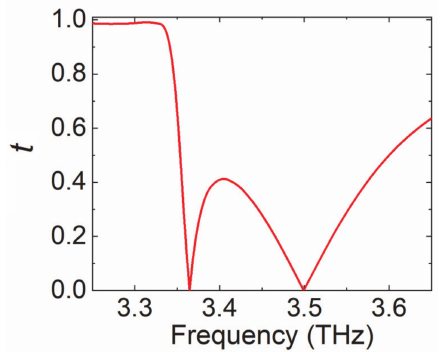
Figure 4. The transmission amplitude of the pure SRR array.